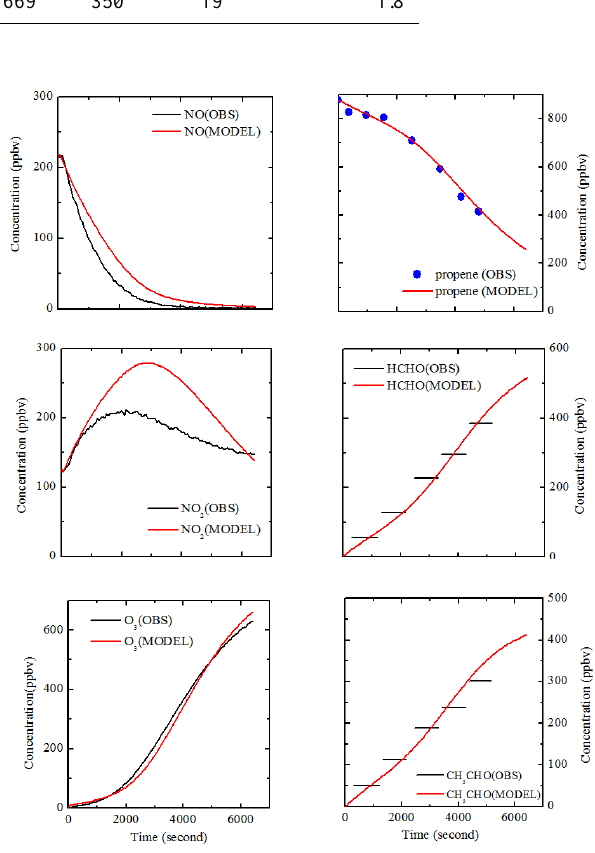
Fig. 6. Concentration–time plots of observed and simulated NO, NO 2 , O 3 , propene, HCHO and CH 3 CHO in a propene–NO x –air irradiation system.